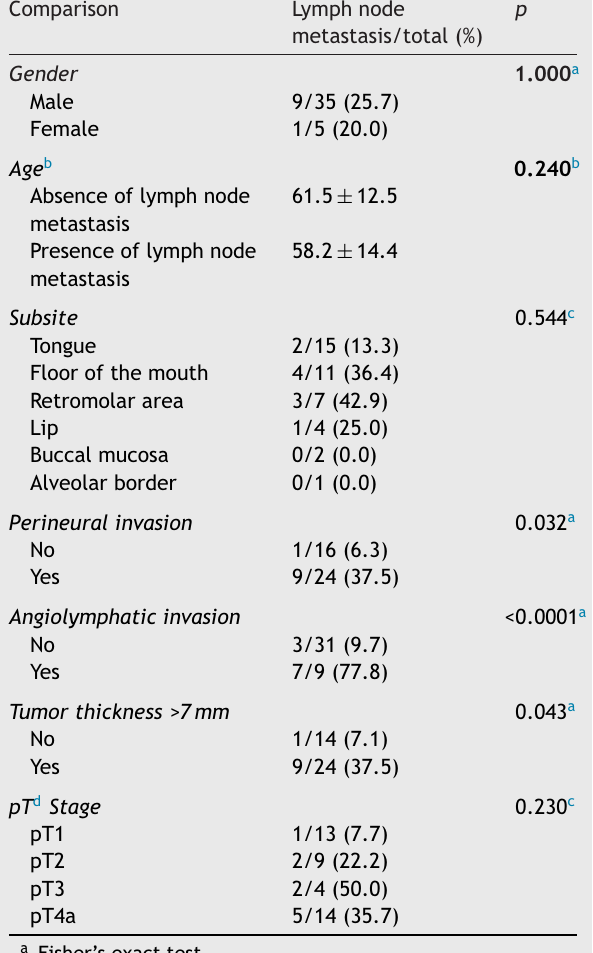
Univariate analysis of factors related to the pres- ence of occult lymph node metastasis.